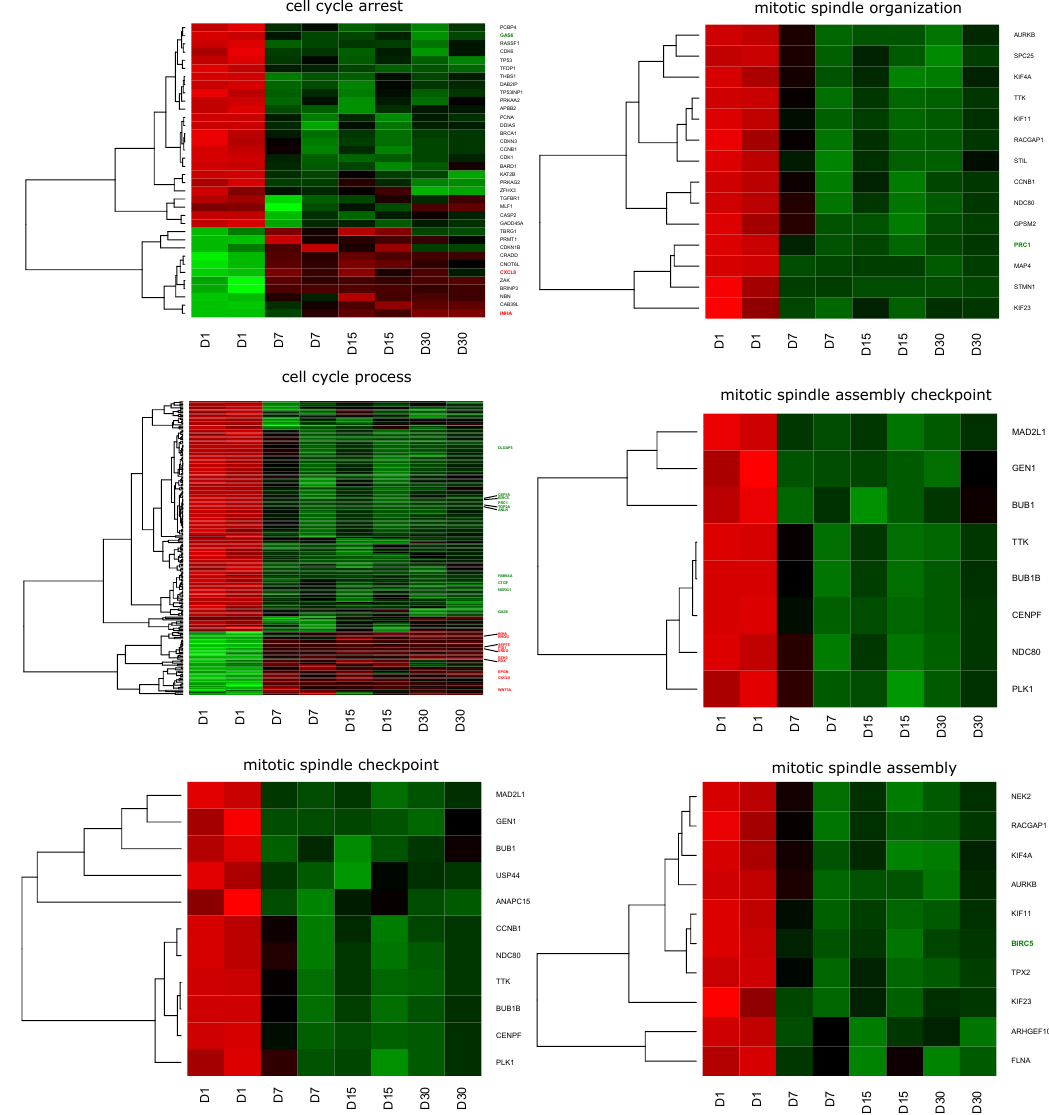
Figure 1. Heat map representation of di ff erentially expressed genes belonging to the “cell cycle arrest”, “cell cycle process”, “mitotic spindle assembly checkpoint”, “mitotic spindle assembly”, “mitotic spindle checkpoint”, and “mitotic spindle organization” gene ontology biological process (GO BP) terms. The arbitrary signal intensity acquired from the microarray analysis is represented by colors (green is higher expression and red is lower expression). Log 2 signal intensity values for any single gene were resized to a row z -score scale (from -2, the lowest expression, to + 2, the highest expression for a single